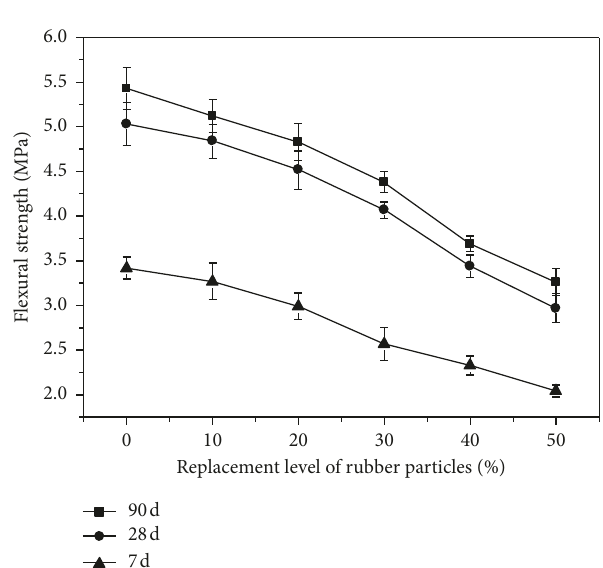
Figure 26: Ratio of flexural strength to compression strength versus replacement level of rubber